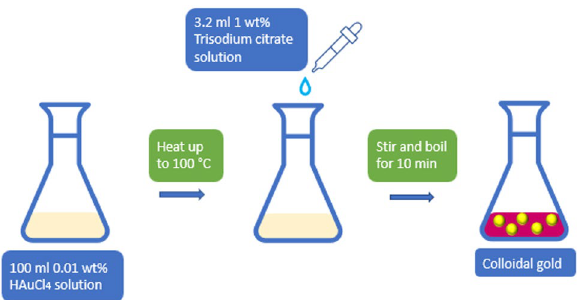
Figure 7. Gold nanoparticle (AuNPs) synthesis by sodium citrate reduction